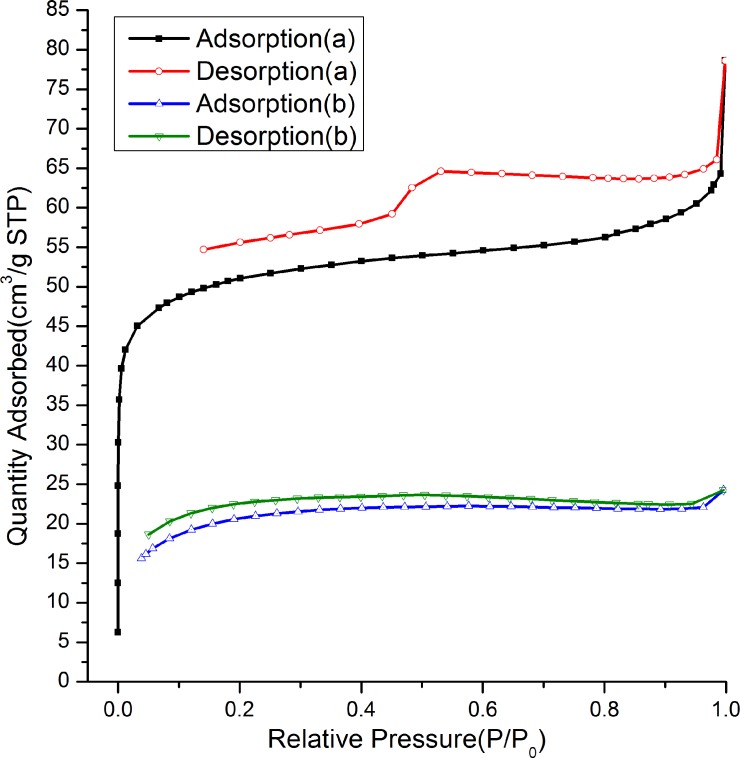
N2adsorption–desorption isotherms of (a) ethanol–HClextracted and (b)calcinedsilicas with the following condition: nTEOS:nCTAB:nDHAA:nNaOH:nH2O = 1:0.114:0.00457:0.5:60.